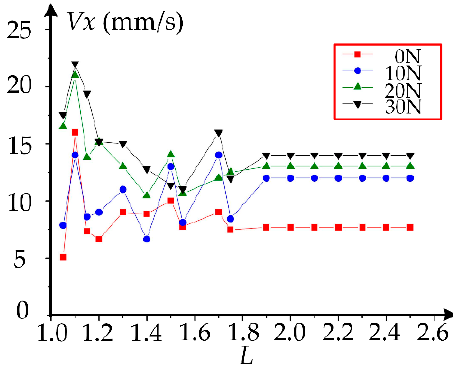
Figure 19. The vibration amplitudes with different axial loads.